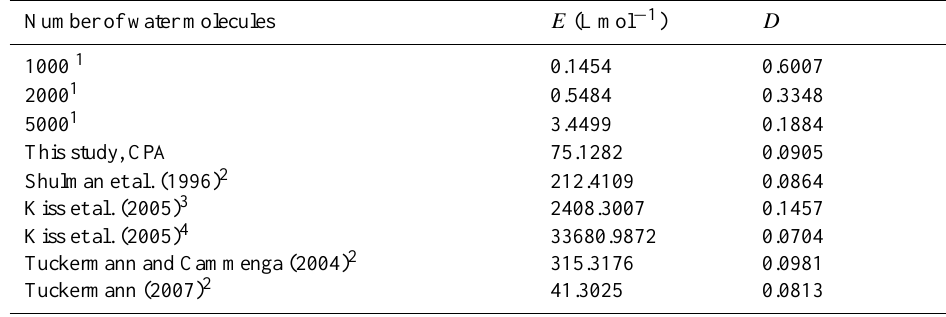
Table 3. Szyszkowski parameters E and D from three different studies.